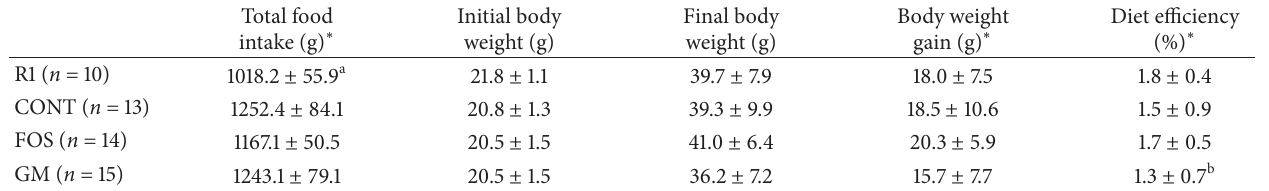
Table 1: Food intake, body weight gain, and diet efficiency of SAMR1 and SAMP8 fed diet containing FOS or GM.